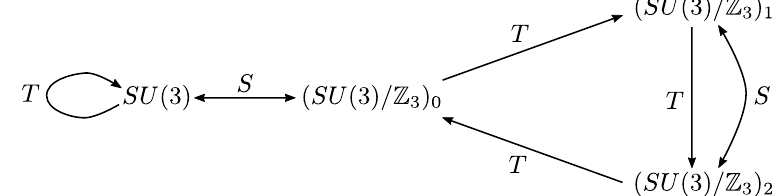
Figure 6. SL(2 ; Z ) duality orbits for the